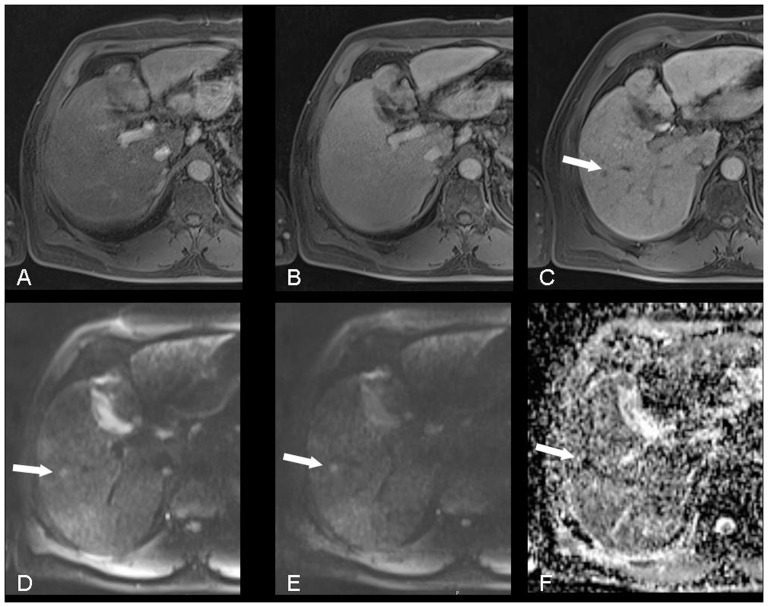
MRI of a 53-years-old male patient with HCC (arrow) in Segment 5: no lesion was identified in the arterial (A) and equilibrium phases (B), a small hypointense lesion was only observed in the hepatobiliary phase (C) and in DWI, where it is seen as a hyperintense lesion in b 50- (D) and b 400-images (E) and hypointense in the ADC-map (F).